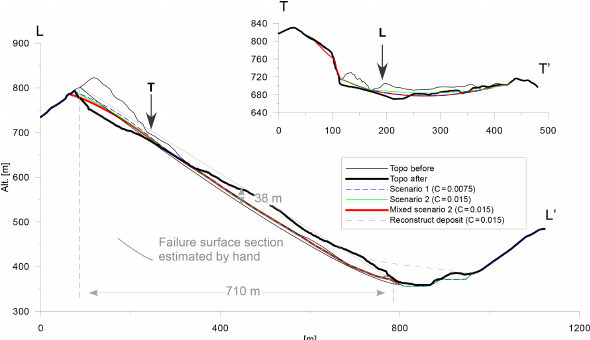
Figure 21. Cross sections of the Akatani-east landslide, displaying different solutions of the SLBL and the deposit reconstruction. The cross section made by hand is illustrated in grey. See Fig. 20 for cross section